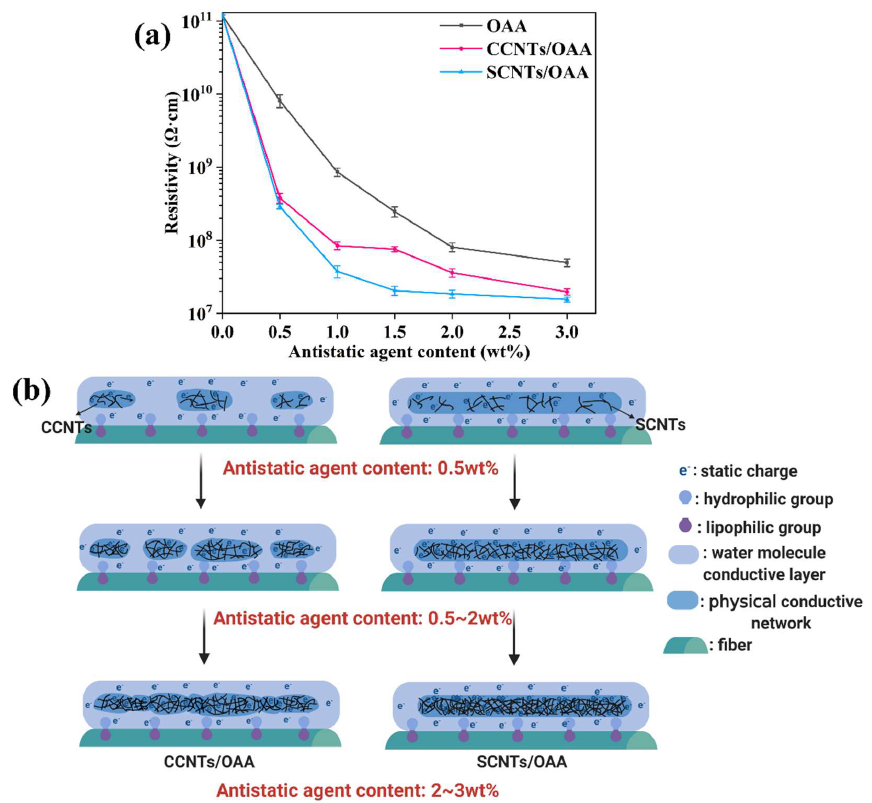
Figure 6. ( a ) Resistivity and ( b ) antistatic mechanism diagram of fiber with different antistatic agent content.